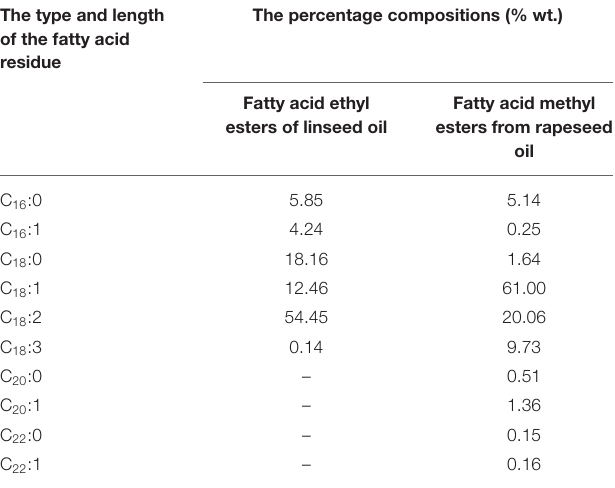
TABLE 1 | The percentage composition of the hydrophobic raw materials